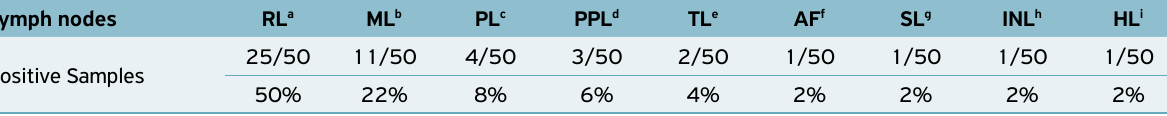
Table 1. Lymph nodes of slaughtered cattle presenting tuberculosis‑like lesions, from an abattoir under federal inspection. Lymph nodes RL a Positive